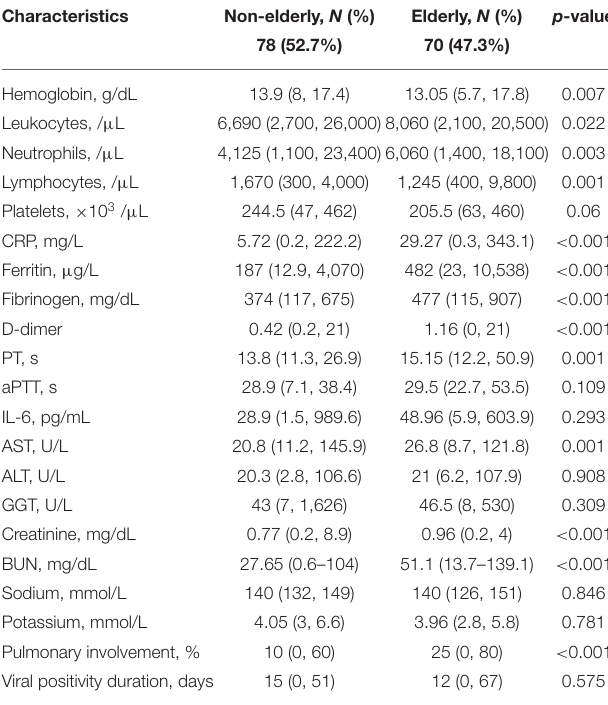
TABLE 2 | Neurological diagnosis. Non-elderly, N (%)